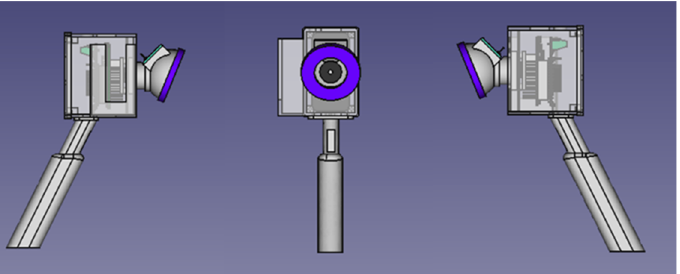
Figure 3. Three-dimensional rendering of different views of the device case designed with FreeCAD 0.19.